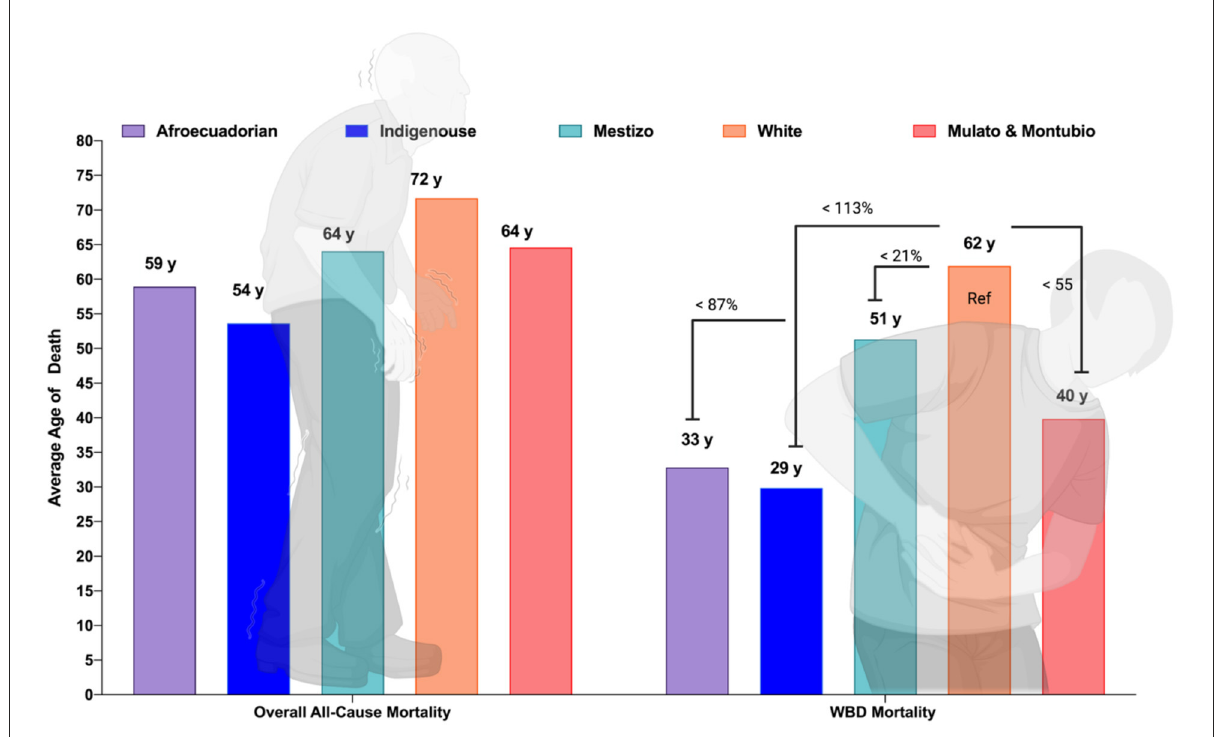
FIGURE3 Average age of death due to all cause’s mortality and WBD in Ecuador by ethnic